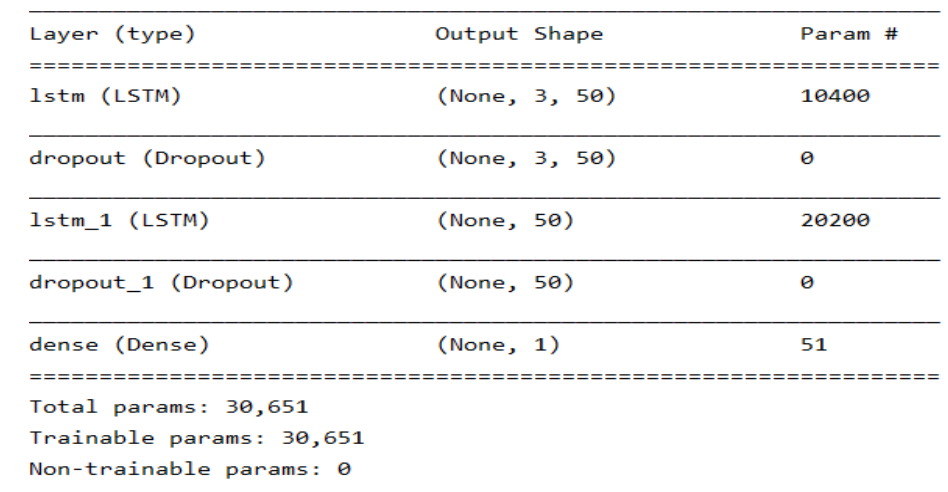
Figure 6. Structure of the output LSTM model.